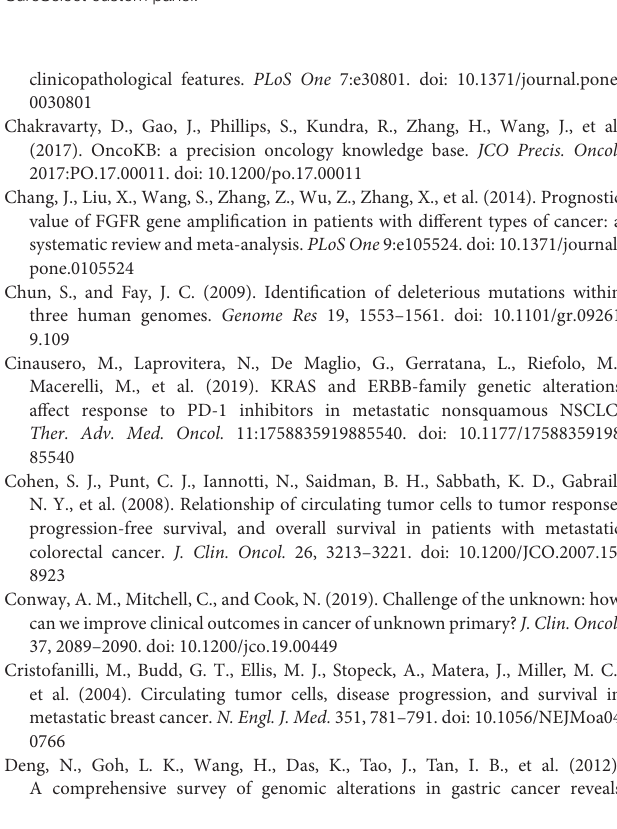
Supplementary Figure 1 | DEPArray NxT representative CTC images from patient #95. Cell gallery acquired by DEPArray, showing single fluorescent channels and overlays, and bright field (BF) images where the DEPArray electrodes (pitch 20 µ m) are visible. Supplementary Figure 2 | Patient #71: Low-Pass Whole Genome CNA profiles. (A) FFPE without compensation: the signal produced by normal cells impact the copy-number alterations (CNA) call. (B) Pure single-CTC: clear CNA calls with digital copy-number values (e.g., Chr 8q n = 4). (C) FFPE analysis set at 70% normal DNA contamination: signal is amplified and, among increased noise, some true positive CNA detected also in CTCs are called (green arrows) along with putative false-positives (orange arrows). Supplementary Figure 3 | Mutational assay and copy number determination assay by Droplet Digital PCR. The graph reports ddPCR outputs of ARID1A mutated fractional abundance (p.R1276X) (A) and in FGFR2 amplification (B) during patient’s follow-up at three different time points. Supplementary Figure 4 | Patient #95 single-CTCs images and CNA profiles. Cell gallery acquired by DEPArray, showing single fluorescent channels and overlays, and bright field (BF) images for 10 CTCs, paired with the corresponding CNA profile. Supplementary Table 1 | List of genes and regions included in SureSelect custom